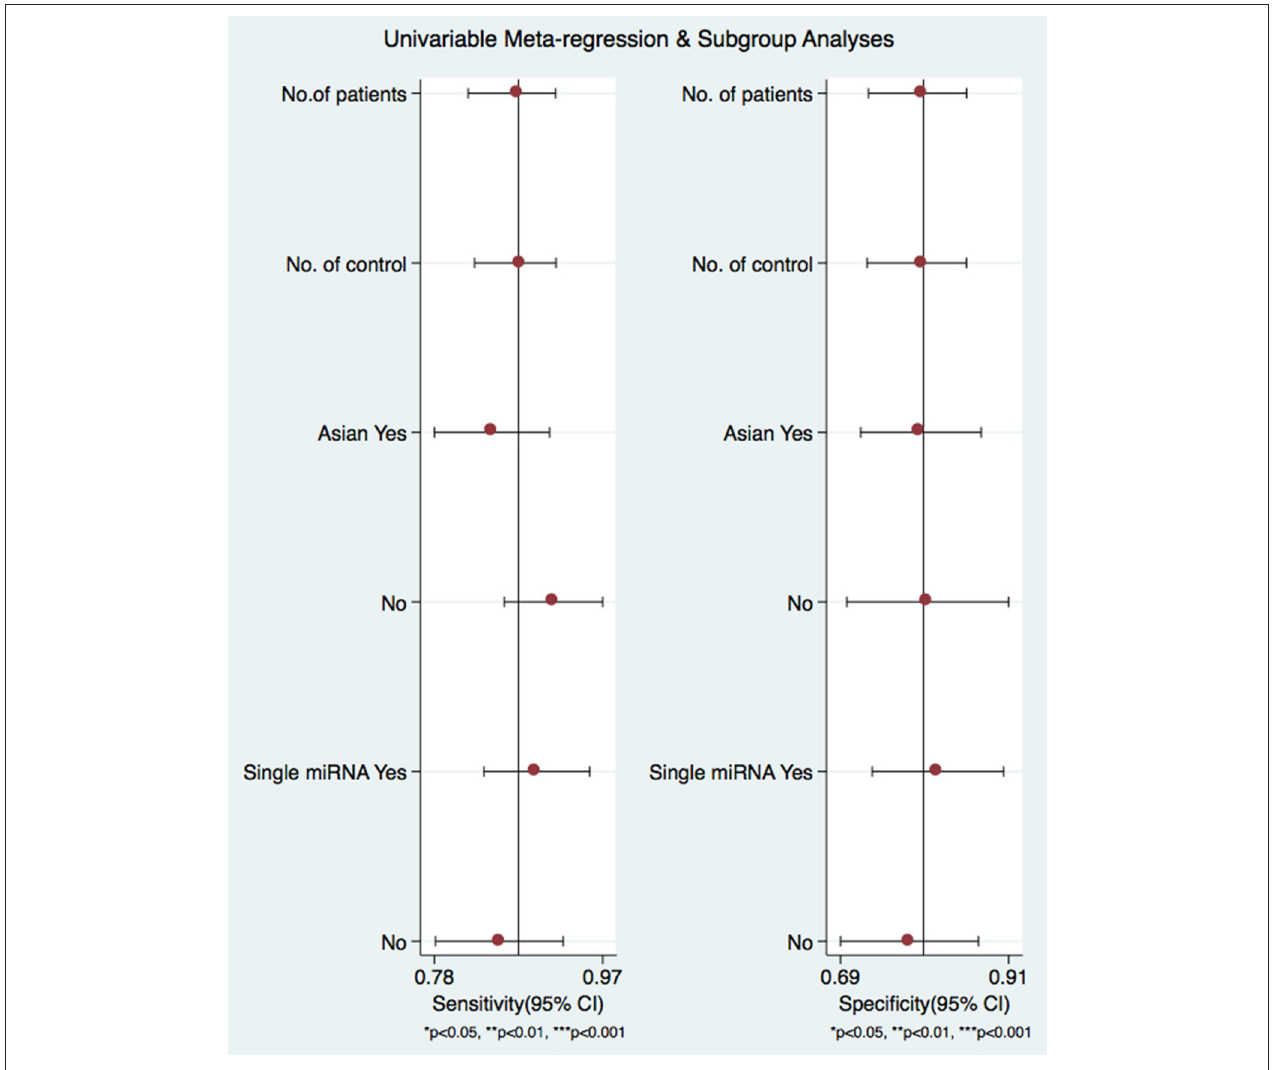
FIGURE 6 | Forrest plots from multivariable meta-regression and subgroup analyses for sensitivity and